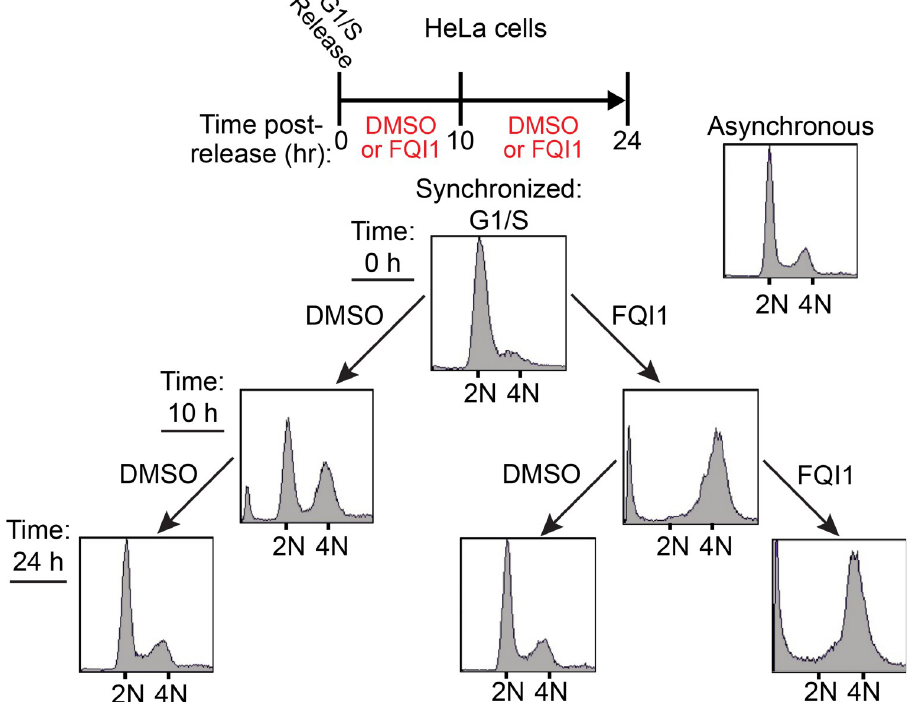
Fig 1. FQI1 treatment induces a rapid and reversible cell cycle arrest with 4N DNA content. Top: Schematic for treatment of HeLa cells following release from a double thymidine block. Cells harvested at 0, 10, and 24 h, as indicated and described in the text, were analyzed for cellular DNA content by propidium iodide staining and flow cytometry. Top right: Asynchronous DNA profile as control.